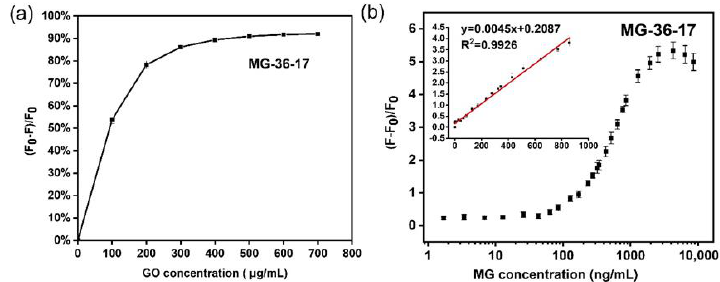
MG-36-12. ( b ) The relative fluorescence intensity of FAM aptamer after incubation with a series of